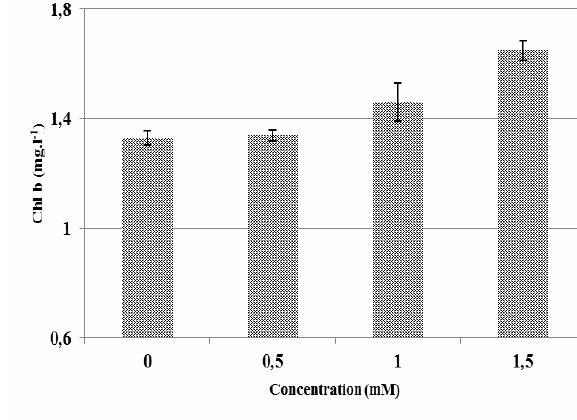
Fig. 1. Effect of different concentrations of SA on ion leakage